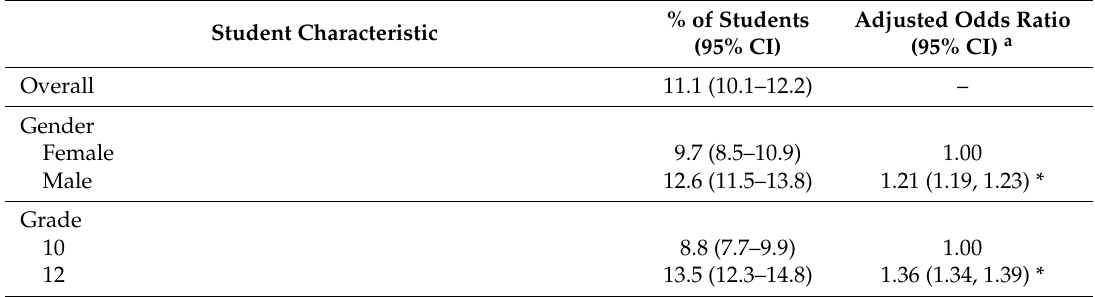
Table 2. Weighted characteristics and correlates of students who reported being offered cigarettes in the last 30 days, 2015–16 California Student Tobacco Survey ( n =